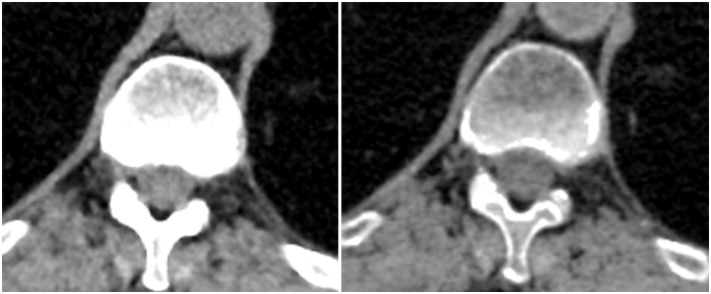
Example of calcium subtraction artifact.Same location in true unenhanced (TUE) image (left) and virtual unenhanced (VUE) image (right). Images are displayed using the same CT window width and window level.